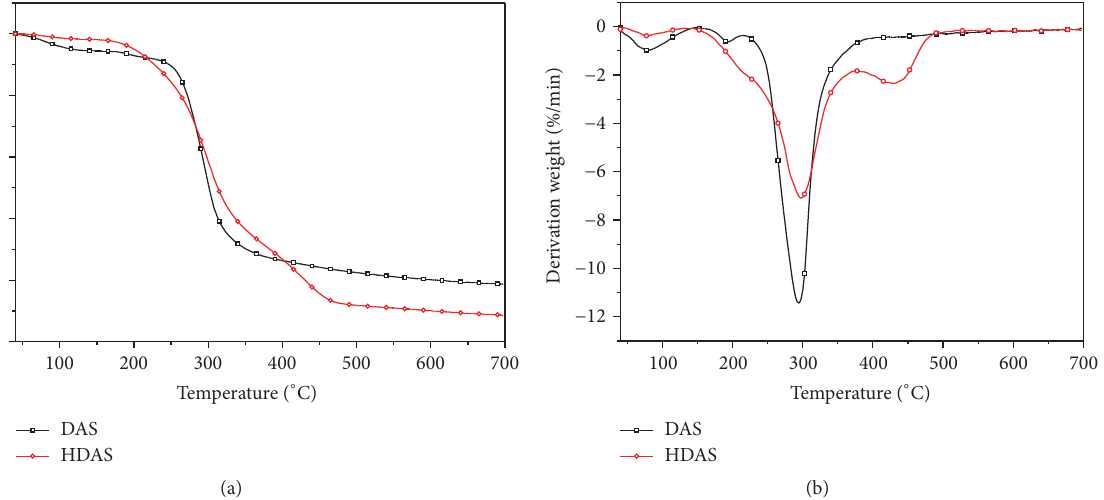
Figure 4: TGA and DTG curves of DAS and HDAS.